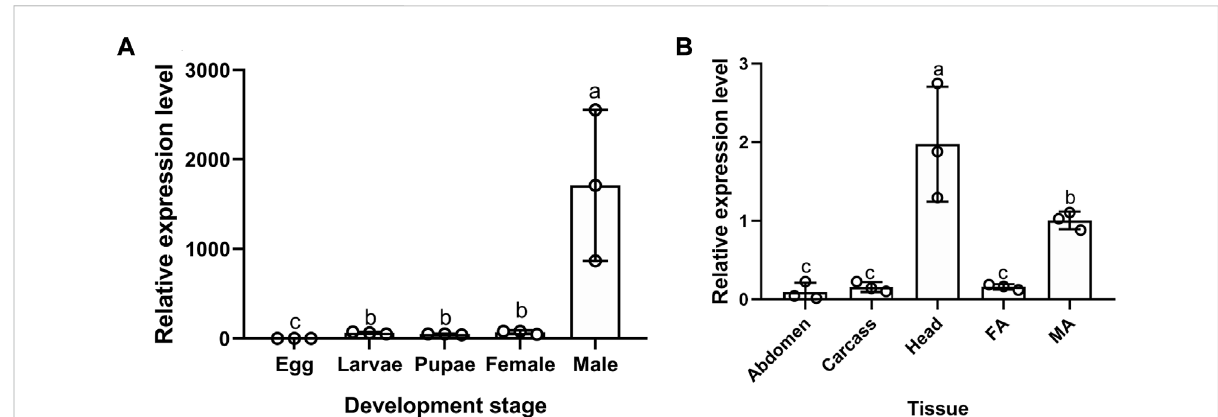
FIGURE 1 Gene expression pro fi ling of CSP4 in different developmental stages (A) and tissues (B) of B. odoriphaga as determined by RT-qPCR. Egg; Larvae; Pupae; Female; Male. Fa: Female antenna; Ma: Male antenna; Male head (without antennae); Carcass: leg + wing + thorax; Abdomen. The expression levels were estimated using the 2 − ΔΔ Ct method. The expression level in eggs was used as a standard to compare expression levels among developmental stages, and the expression level in male antennae was used as a standard to compare expression levels among tissues. Values are means ± SE; means with different letters are signi fi cantly different ( p <